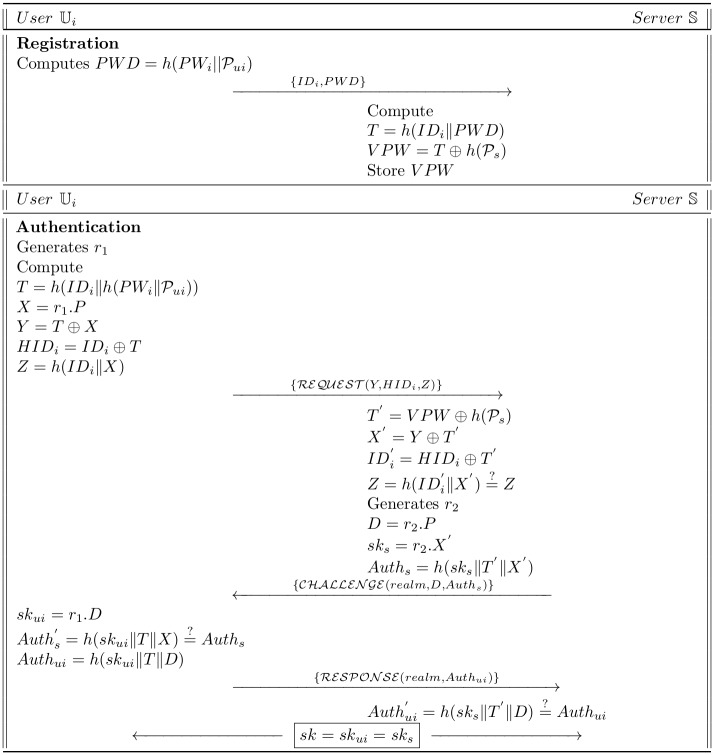
Lu et al.’s scheme.